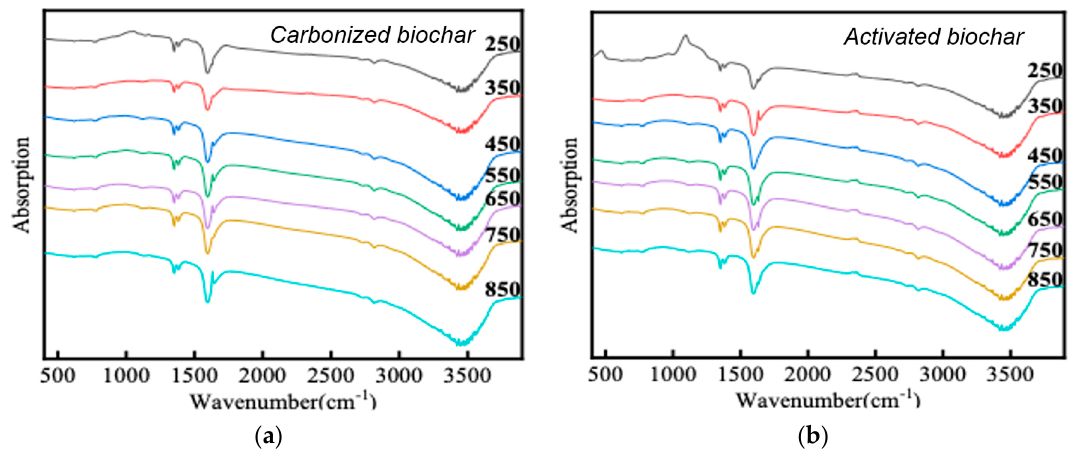
Figure 3. FTIR spectrum of carbonized biochars ( a ) and activated biochars ( b ).